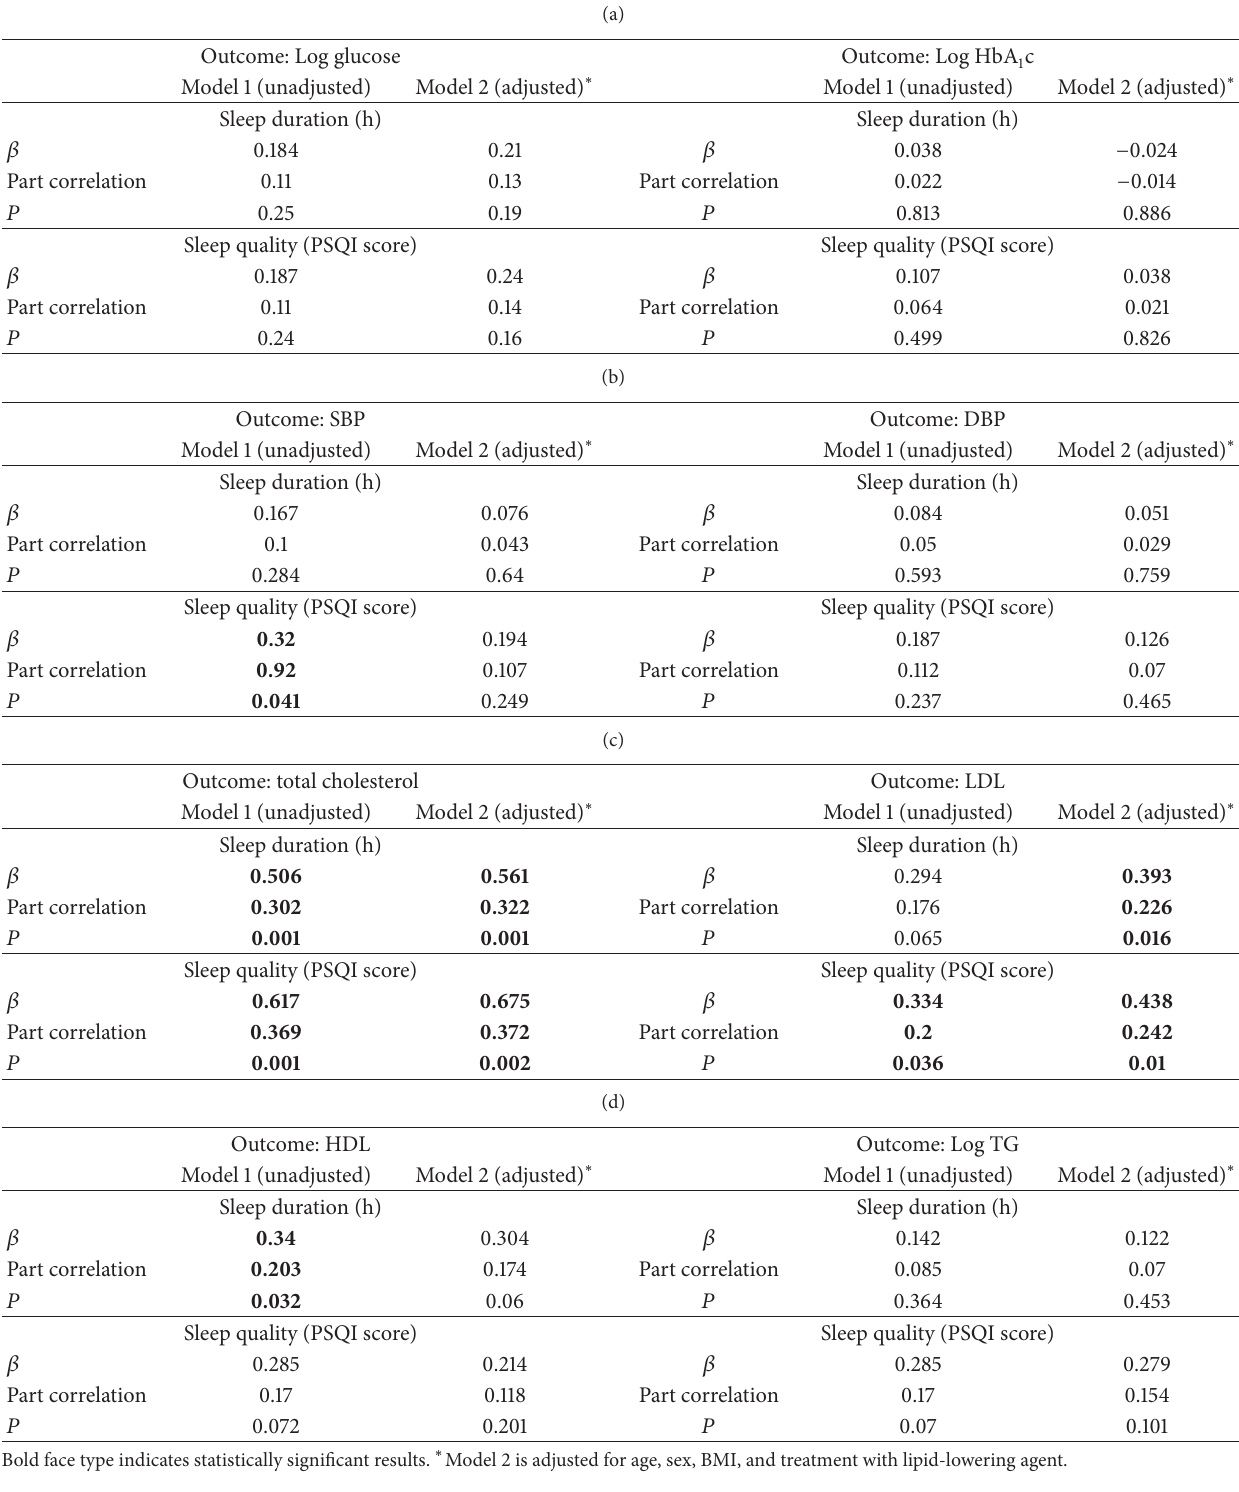
Table 3: Standard and hierarchical multiple regression analyses predicting the natural log glucose and log HbA (Table 3(b)), total cholesterol and LDL (Table 3(c)), and Log TG and HDL (Table 3(d)), from sleep duration and sleep